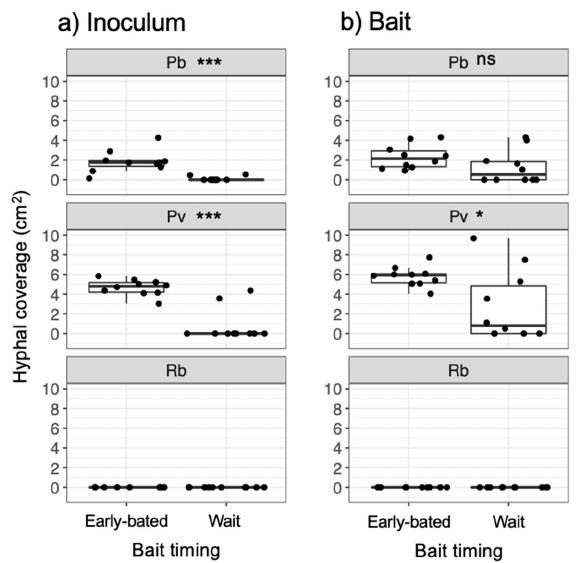
Figure 5. Hyphal coverage (cm 2 ) of mycelia extending from ( a ) inoculum and ( b ) bait wood